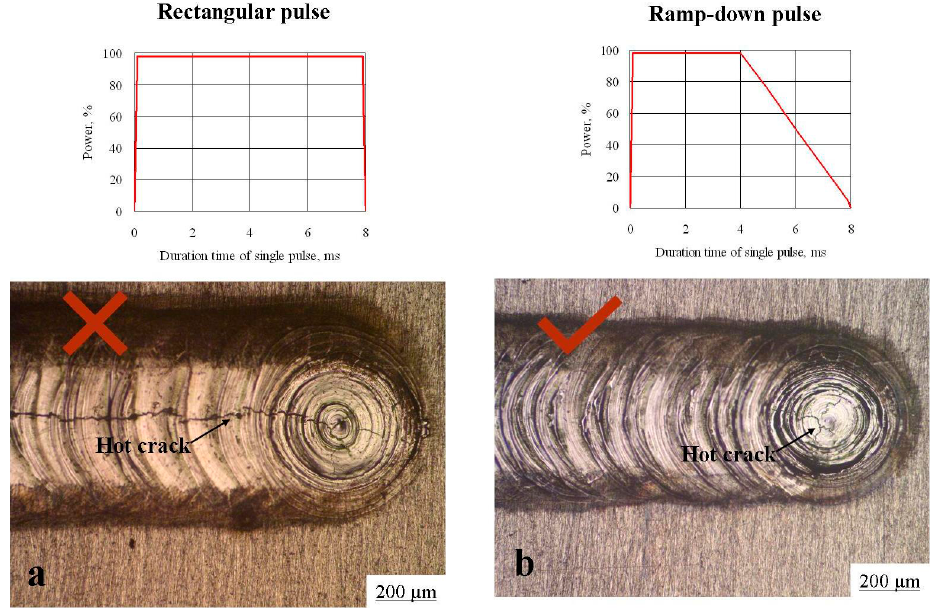
Figure 1. As-cast structure of the welded seam of the Al-4.7Mg-0.32Mn-0.21Sc-0.1Zr alloy.